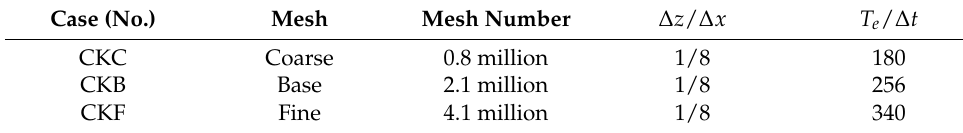
Table 3. Test cases for mesh convergence ( λ / L pp = 1, H / λ = 1/60, V = 15.5 knots). Case